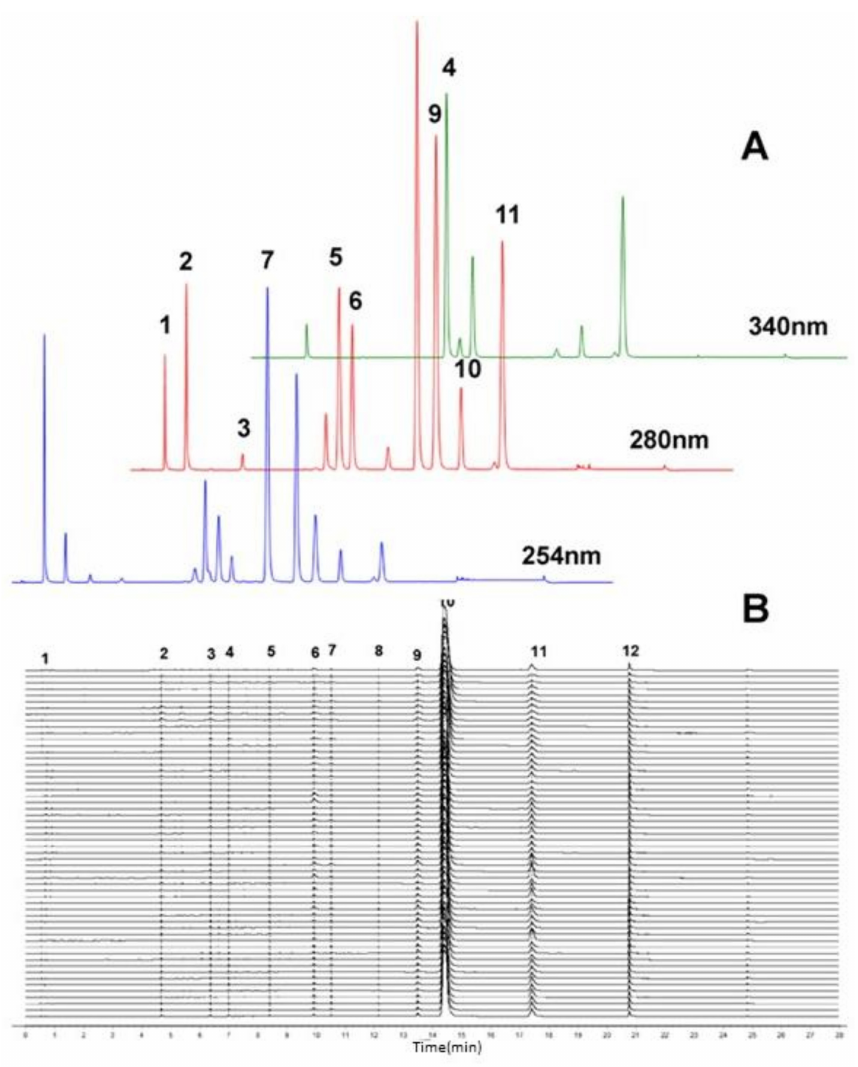
Figure 2. Multiple chromatograms ( A ) of 11 constituents of CC: 1 Pro; 2 Le; 3 Prod; 4 Con; 5 Cou; 6 Hc; 7 Cal; 8 Cac; 9 Cin; 10 Mca and 11 Mc; Similarity analysis ( B ) of the 11 constituents of 42